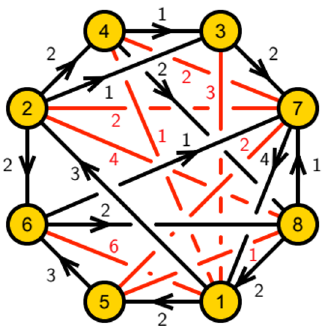
Figure 30 . Quiver for Model